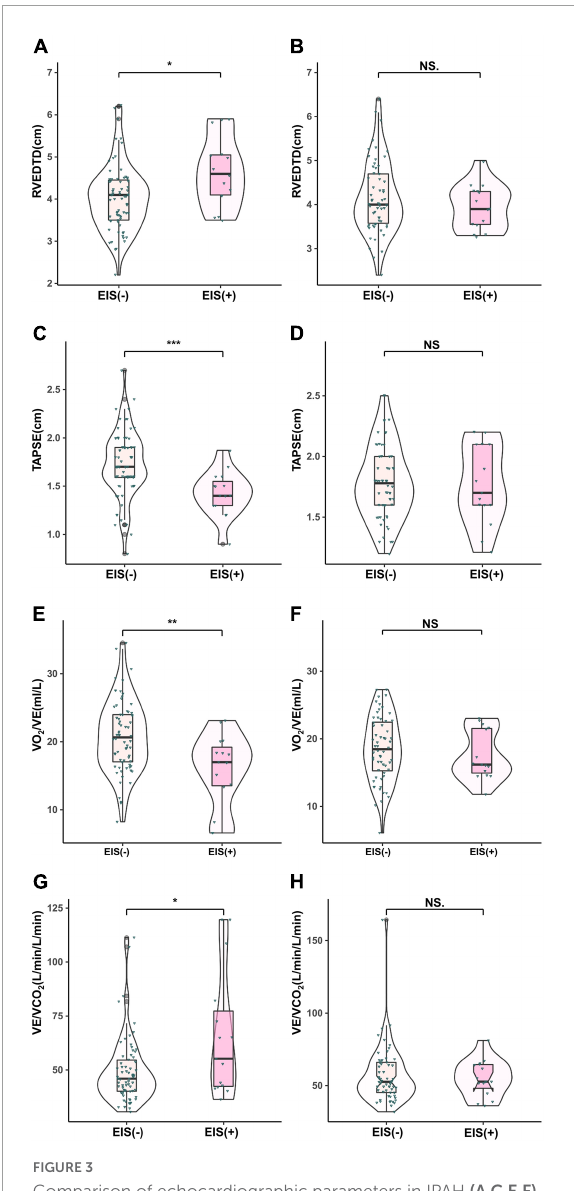
FIGURE2 Comparison of hemodynamic parameters in IPAH and CTEPH patients stratified by EIS ( + ). * P < 0.05. IPAH, idiopathic pulmonary arterial hypertension; CTEPH, chronic thromboembolic pulmonary hypertension; EIS, exercise-induced right-to-left shunt; CO, cardiac output; CI, cardiac index; PVR, pulmonary vessel resistance; SvO 2 , mixed venous oxygen saturation. (A,C,E,F) , IPAH; (B,D,G,H) , CTEPH.